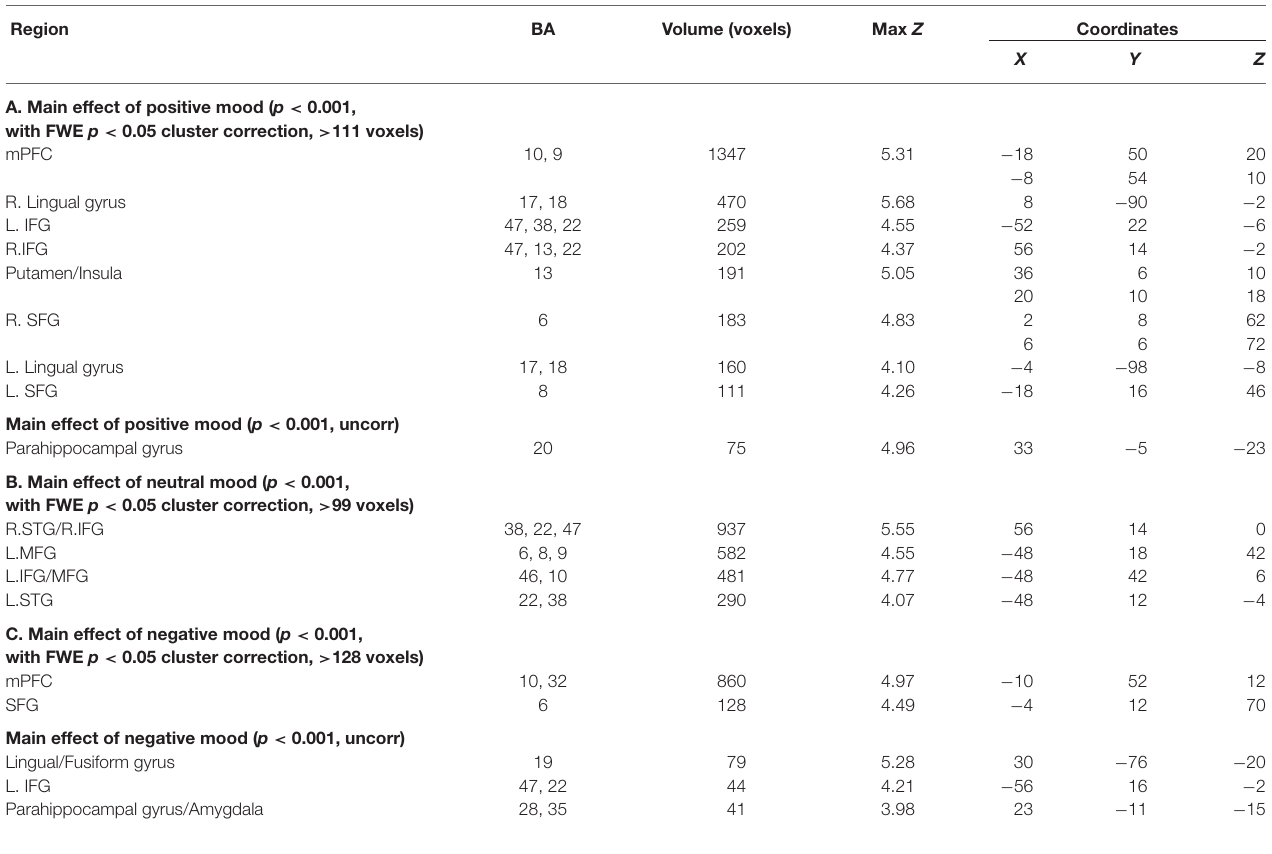
TABLE 2 | Whole-brain neural activity induced by each mood state. Region BA Volume